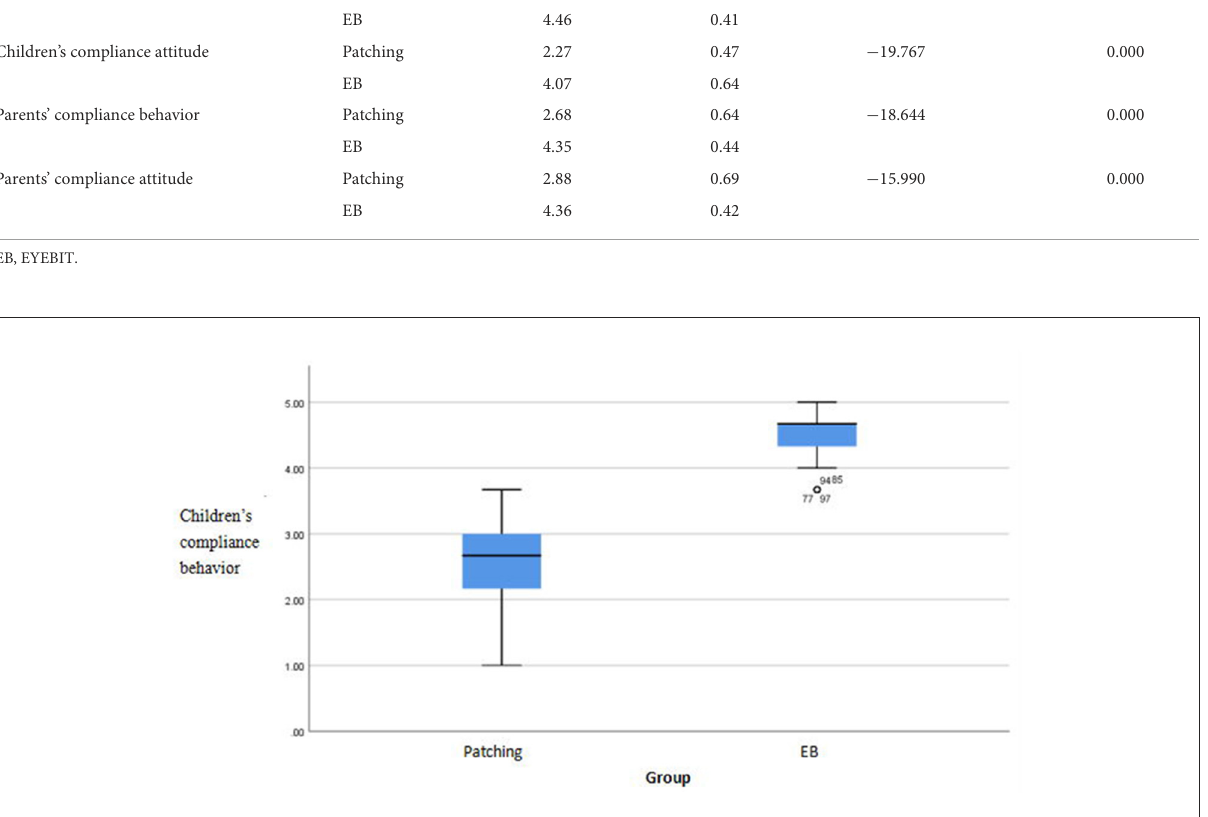
FIGURE4 Box plots of children’s compliance behavior on two training methods. EB, EYEBIT.